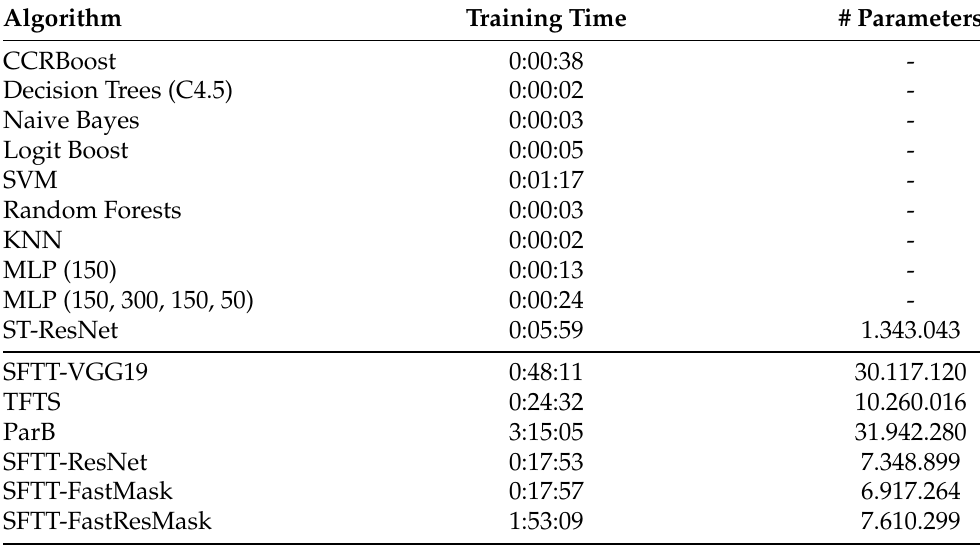
Table 1. Complexity of all algorithms in total training time for the “All Crimes” crime type in the Philadelphia dataset and number of trainable parameters for the DL architectures.